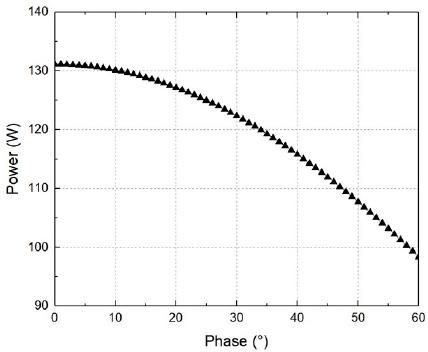
Figure 15. Simulated output power depending on the phase difference of the two input signals of the adaptive power combiner.